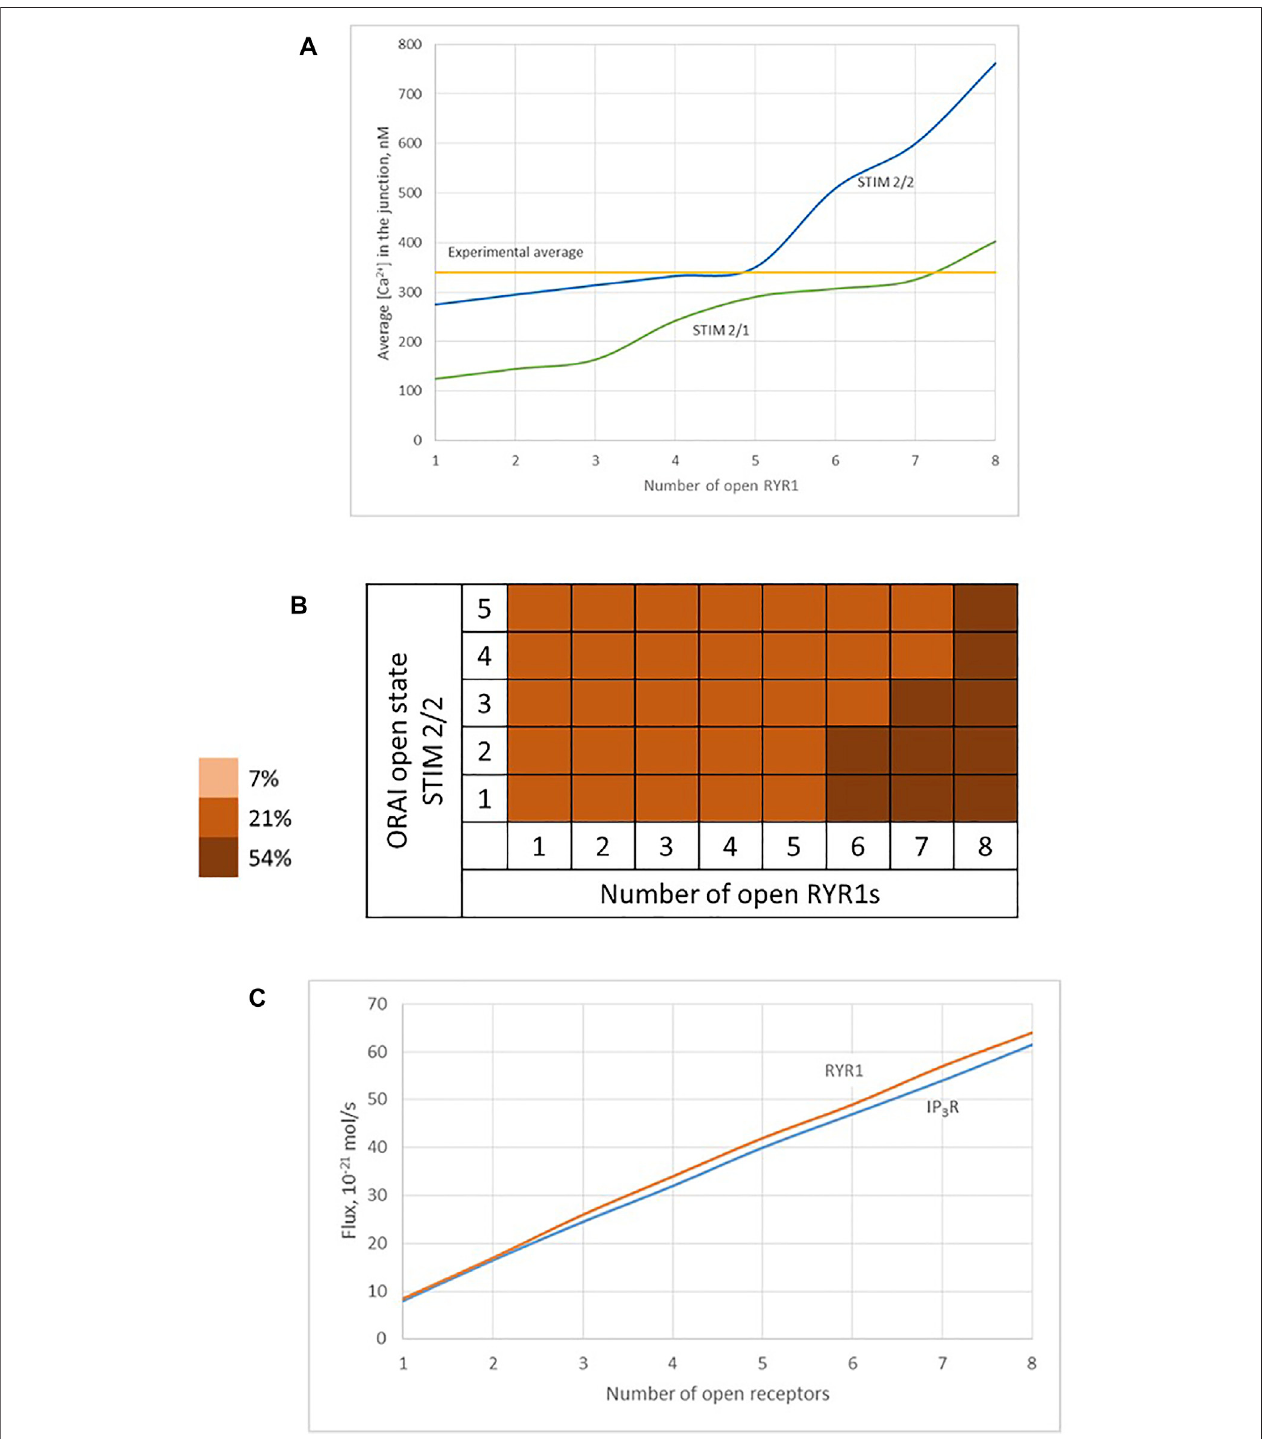
FIGURE9| In fl uenceofthenature ofthe ERCa 2+ channelinducingthelocaldepletionofERCa 2+ (IP 3 RorRYR1) and oftheSTIMisoformsbound toORAI1on the characteristics of Ca 2+ microdomains (A) Evolution of Ca 2+ microdomains amplitude with the number of simultaneously open RYR1 in the junction. The microdomains observedinconditionsoffullERcanbeinducedbythespontaneousopeningofafewRYR1nearthejunctionthatinturntriggertheopeningofORAI1channelsboundto STIM2/2(bluecurve)ortoSTIM1/2(greencurve).ORAI1channelsopentoanextentthatdependsonlocalERCa 2+ concentration,asde fi nedbythecorresponding function f 2 or f 2/1 (see Supplementary Information ) (B) Individual evolution between the 5 open states of the ORAI1 (Li et al., 2011), as a result of 1 – 8 RYR1 opening simultaneously. (C) Comparison of Ca 2+ fl uxes through open IP 3 Rs and RYR1. Because of the slow replenishment around the pore of the receptor channel with D S = 10 μ m 2 /s, the concentration gradient around the two extremities of the pore does not changes drastically and hence the fl ux remains of the same order for IP 3 Rs and RYR1.